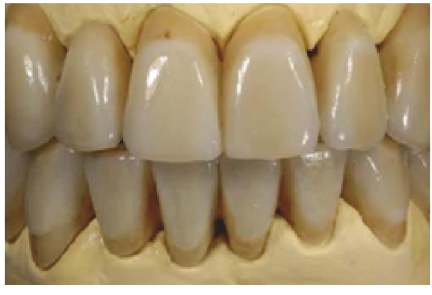
Figure 19: Final restorations, frontal